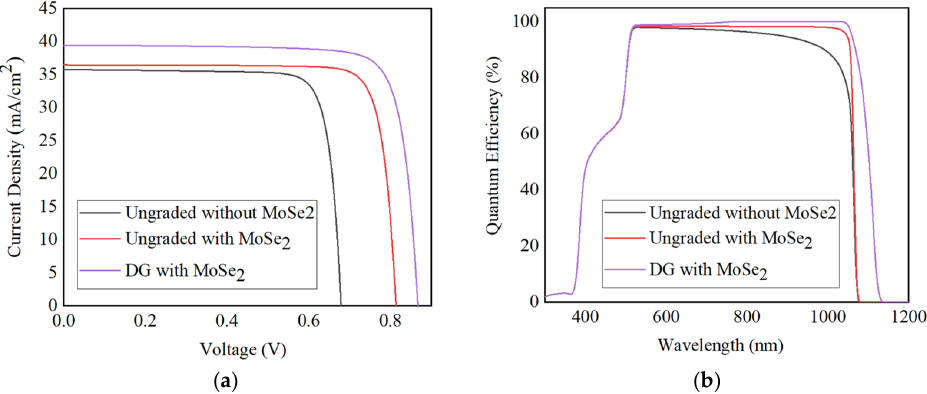
Figure 11. ( a ) J-V characteristics and ( b ) quantum efficiency curves of CIGS cells simulated in this study with/without MoSe 2 and with DG bandgap grading profile in the absorber layer.